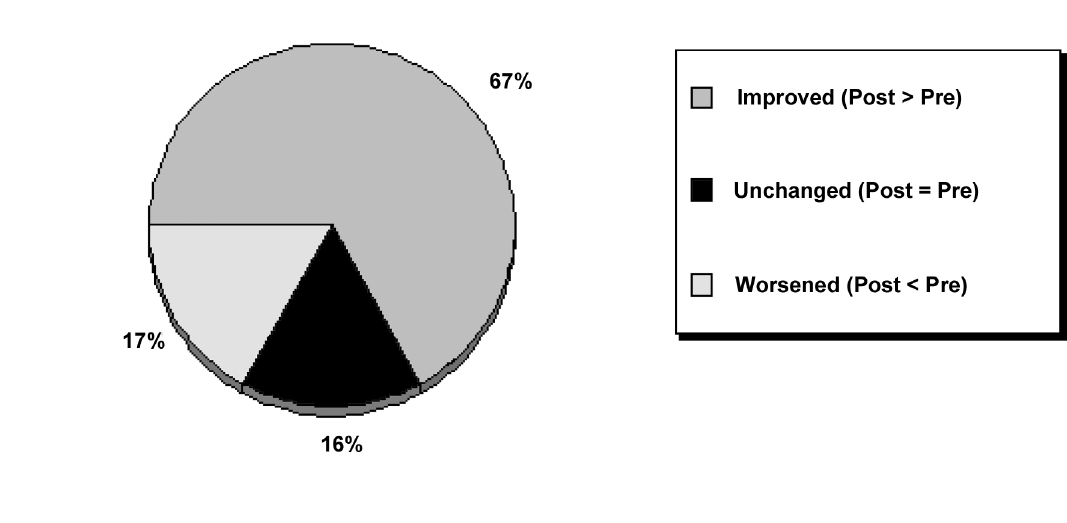
Figure 2 – Comparison between total scores on the IIEF applied on visits 1 and 2 (n =